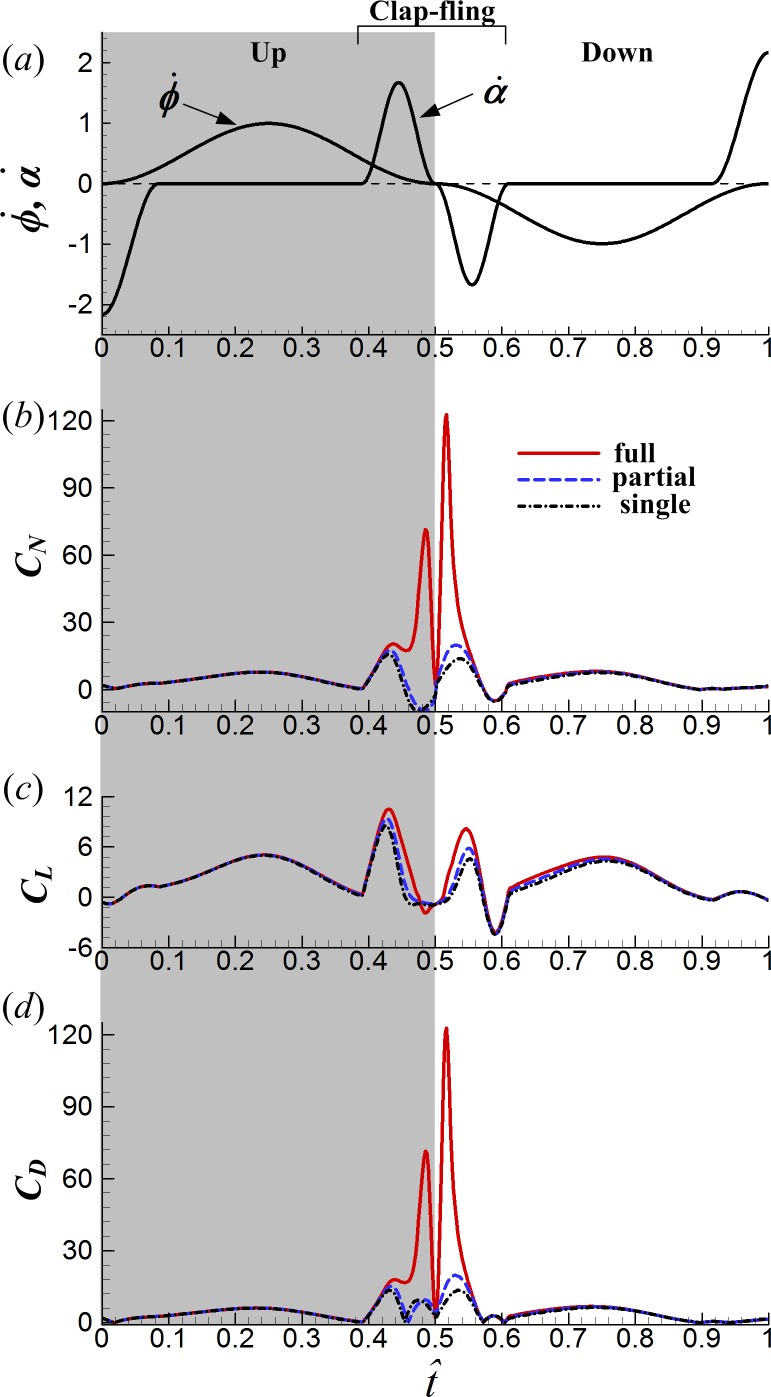
Time courses of the wing motion and force coefficients in one cycle for the three different cases: (A) non-dimensional angular velocity of rotation \documentclass[12pt]{minimal}
\usepackage{amsmath}
\usepackage{wasysym}
\usepackage{amsfonts}
\usepackage{amssymb}
\usepackage{amsbsy}
\usepackage{upgreek}
\usepackage{mathrsfs}
\setlength{\oddsidemargin}{-69pt}
\begin{document}
}{}$(\dot {\alpha })$\end{document}α ˙ and translation \documentclass[12pt]{minimal}
\usepackage{amsmath}
\usepackage{wasysym}
\usepackage{amsfonts}
\usepackage{amssymb}
\usepackage{amsbsy}
\usepackage{upgreek}
\usepackage{mathrsfs}
\setlength{\oddsidemargin}{-69pt}
\begin{document}
}{}$(\dot {\phi })$\end{document}ϕ ˙; (B) the normal force coefficient; (C) the lift coefficient; (D) the drag force coefficient.